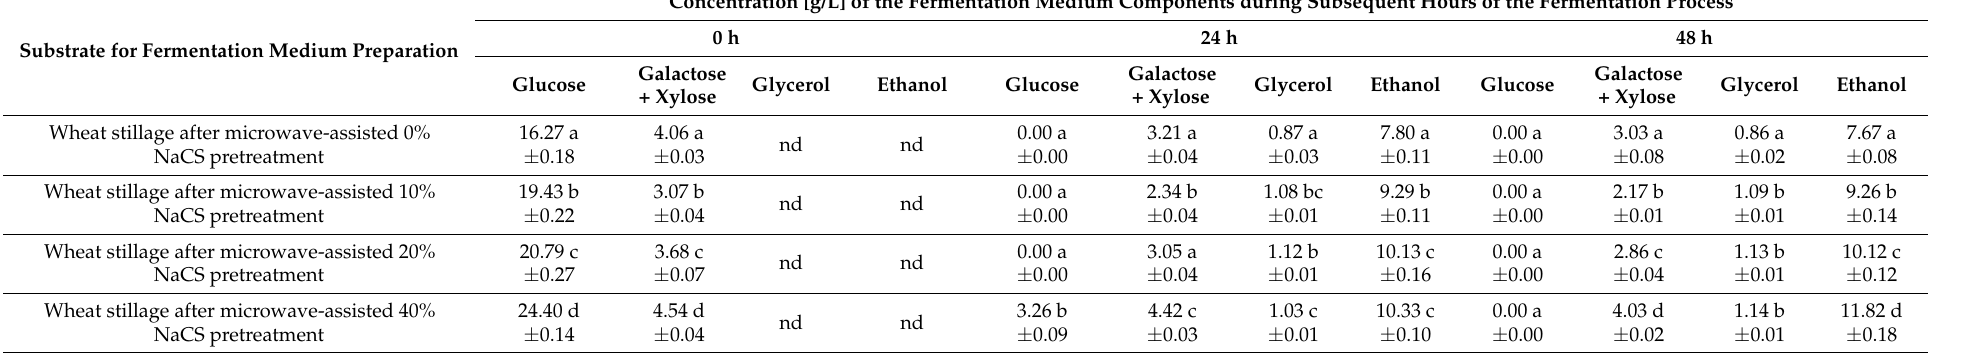
Table 2. Composition of the fermentation medium during subsequent hours of the fermentation process using wheat stillage in 100 g/L concentration after microwave-assisted pretreatment with